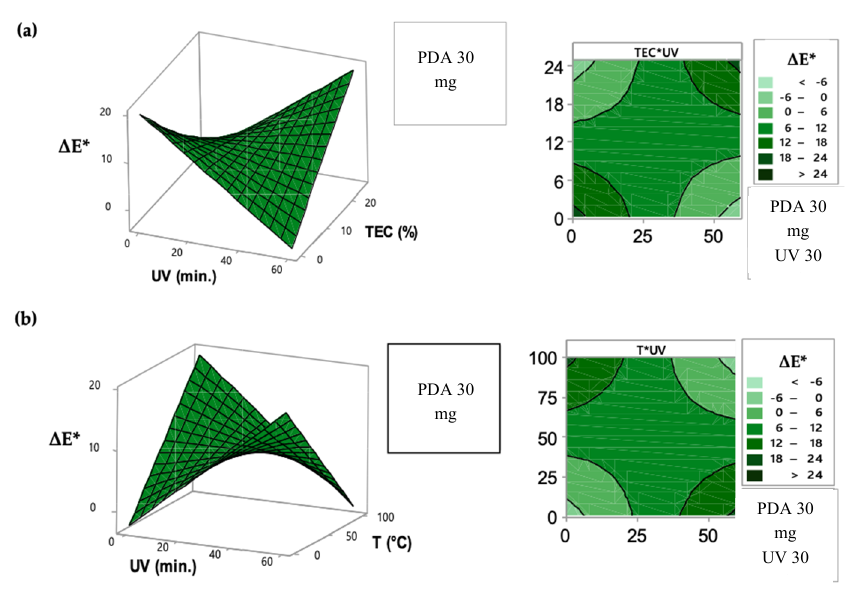
Figure 3. Response surface and contour graphic to the adjusted surface for the ∆ E* factor as a function of: ( a ) UV-time exposure and TEC concentration; ( b ) UV-time exposure and temperature conditions on the intelligent films.